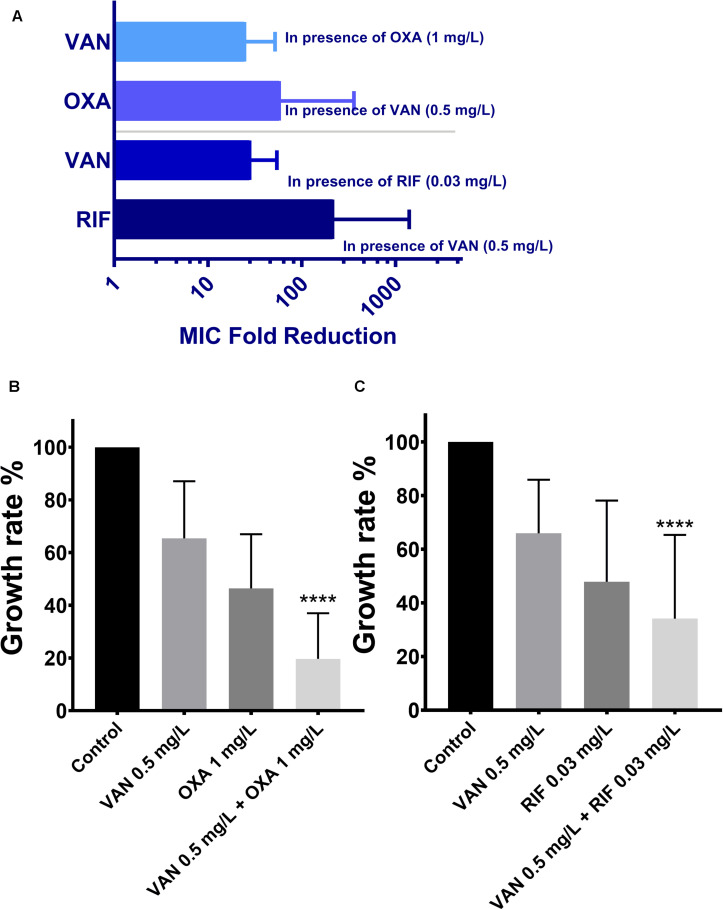
The therapeutic effectiveness of vancomycin combining oxacillin and vancomycin combining rifampicin against the 113 wild-type MRSA strains. The error bars were estimated by 113 biological replicates. (A) Fold reduction of MICs in presence of the partnering antibiotics. (B,C) Growth rates of drug-free, vancomycin only, oxacillin only, rifampicin only, combination of vancomycin and oxacillin, and combination of vancomycin and rifampicin. ****Significant difference between combination groups and other groups (control and single drug); P < 0.0001, one-way ANOVA.